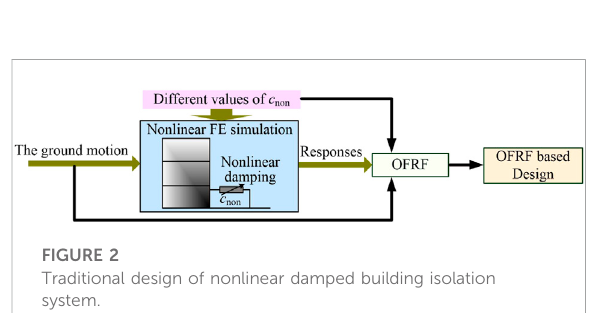
New mobility based design of nonlinear damped building isolation